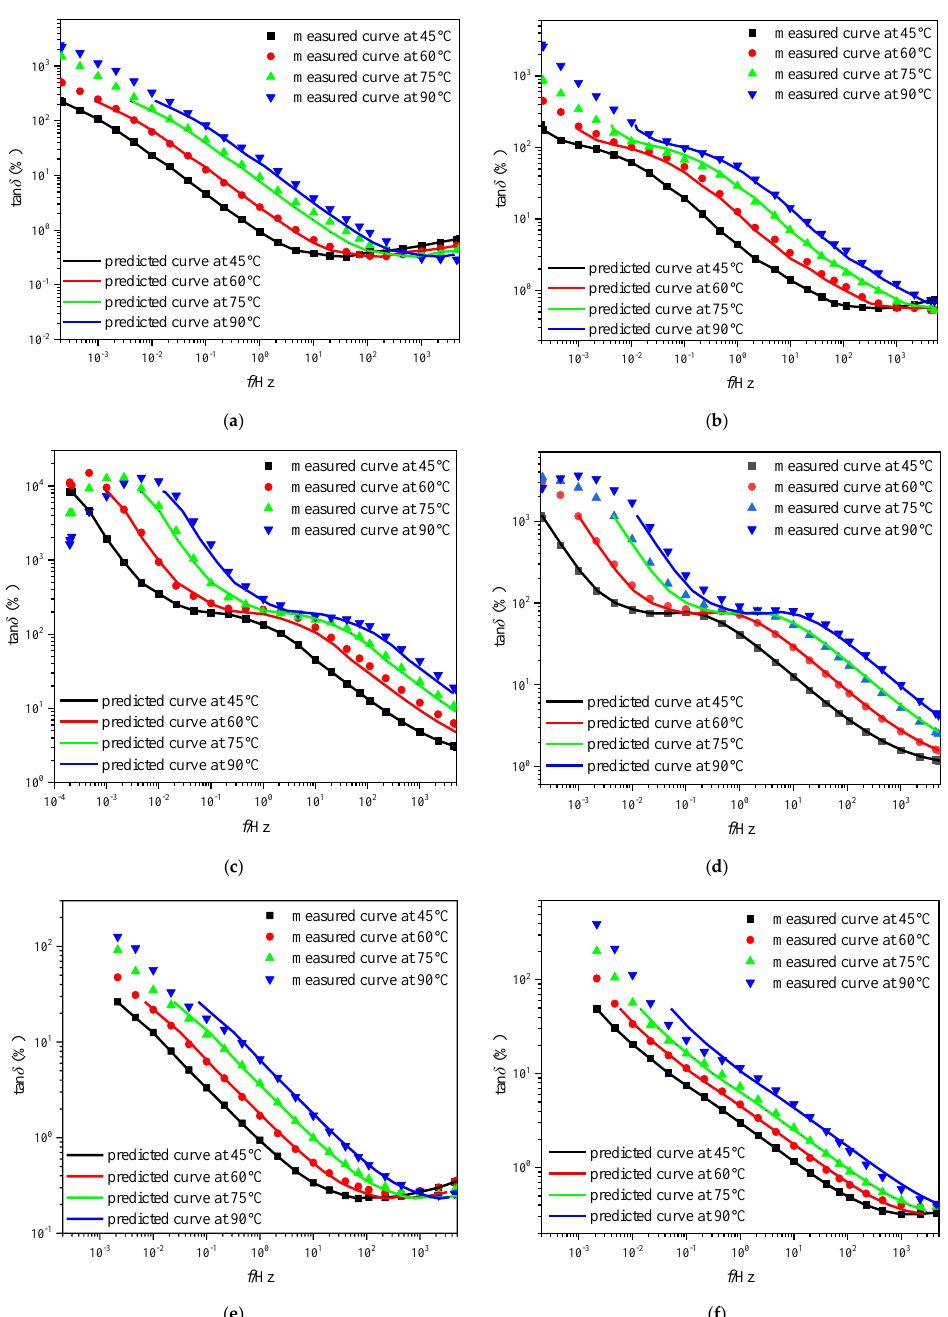
Figure 7. The verification test of the reported universal approach for temperature correction. ( a ) DP = 425, mc% = 1.2%, ( b ) DP = 994, mc% = 2.8%, ( c ) DP = 841, mc% = 3.7%, ( d ) DP = 1285, mc% = 4.0%, ( e ) DP = 663, mc% = 0.9%, ( f ) DP = 640, mc% = 1.3%.